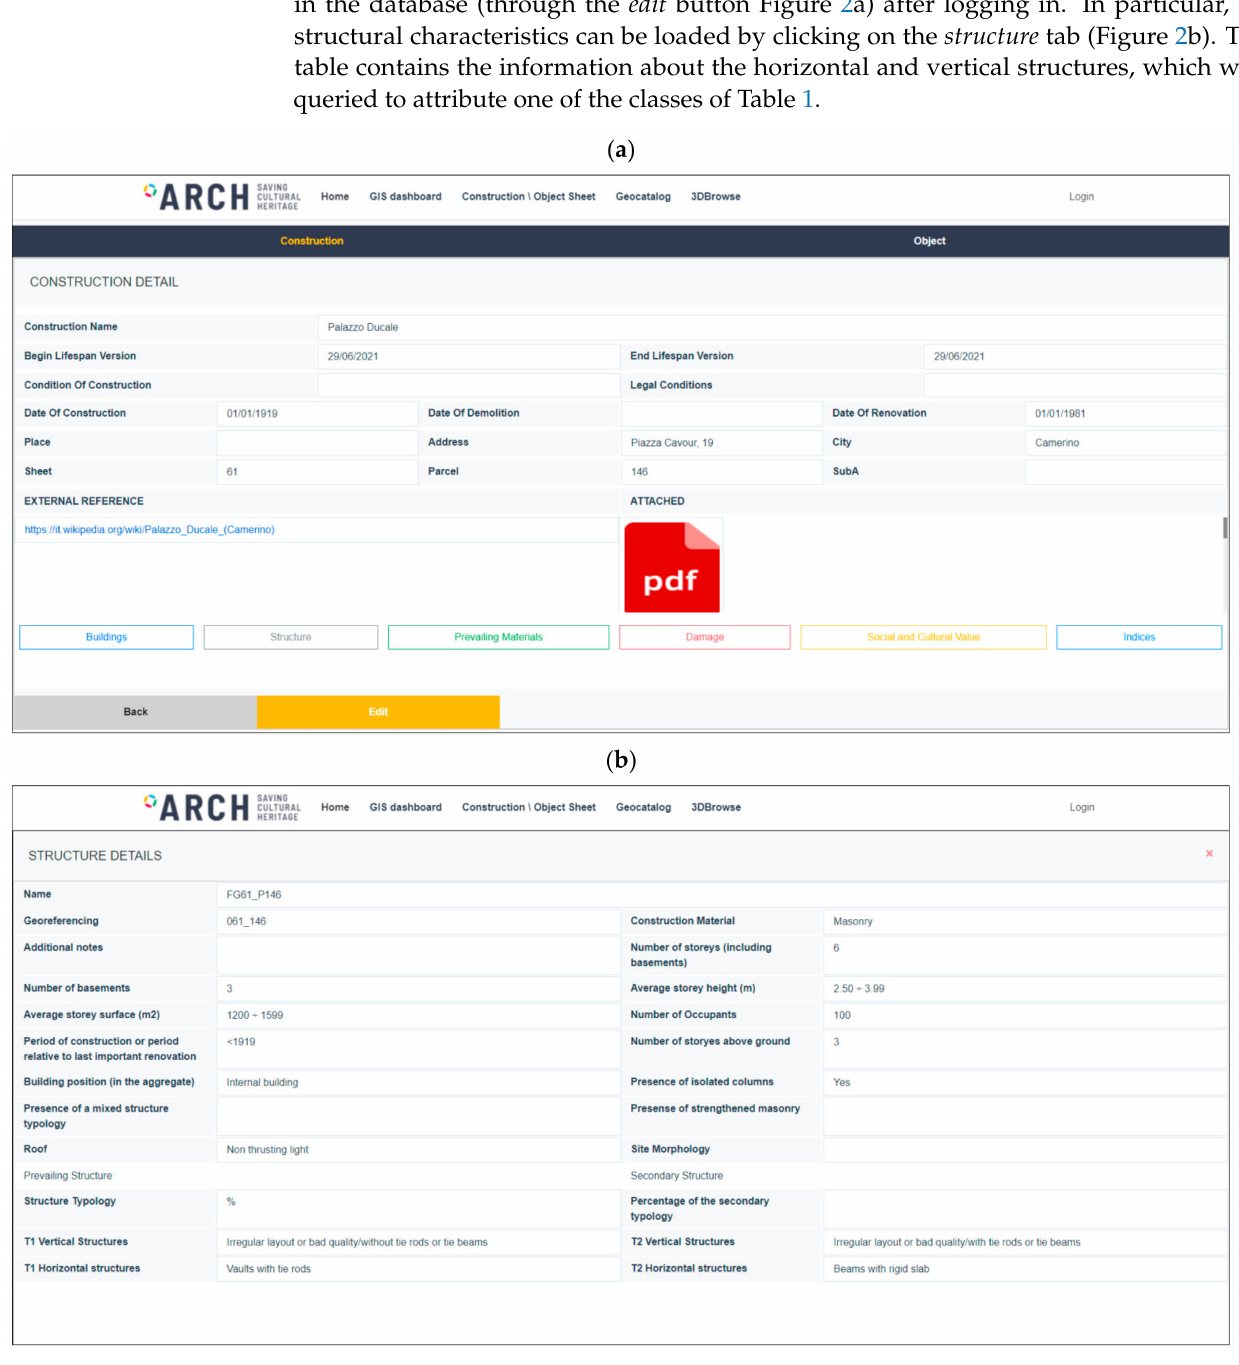
Figure 2. Tools of the ARCH Historic Area Information System: construction sheet with general information about the construction ( a ) and detail of the structure tab with the structural information ( b